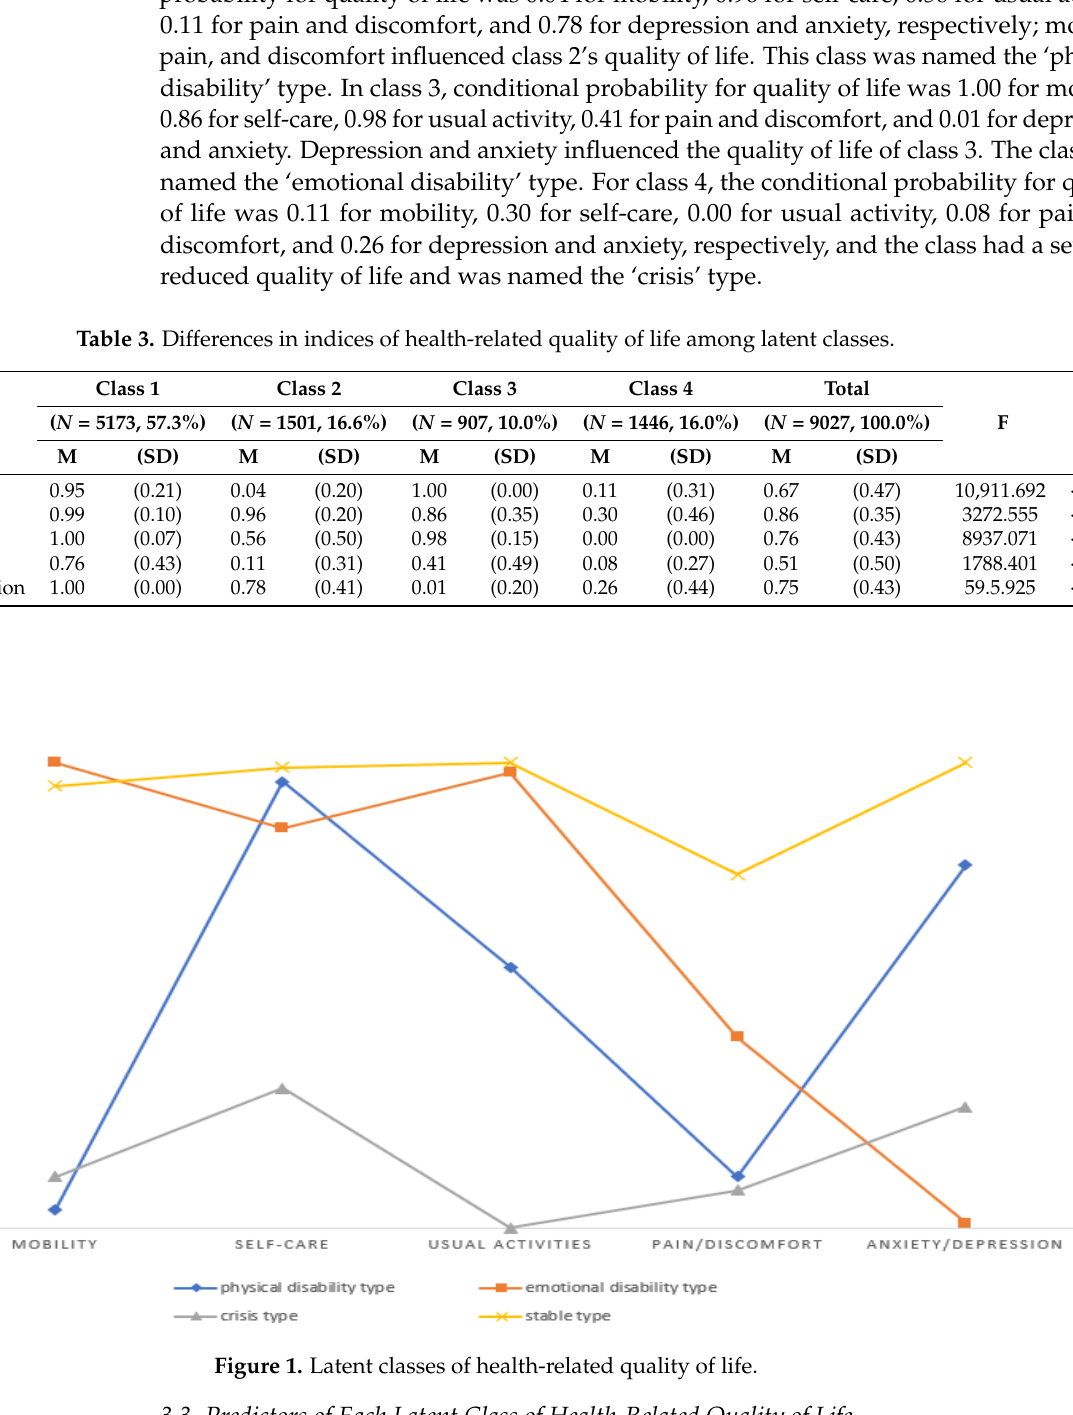
Table 2. Fit indices of latent class analysis and distribution rate of HRQOLs (EQ-5D).